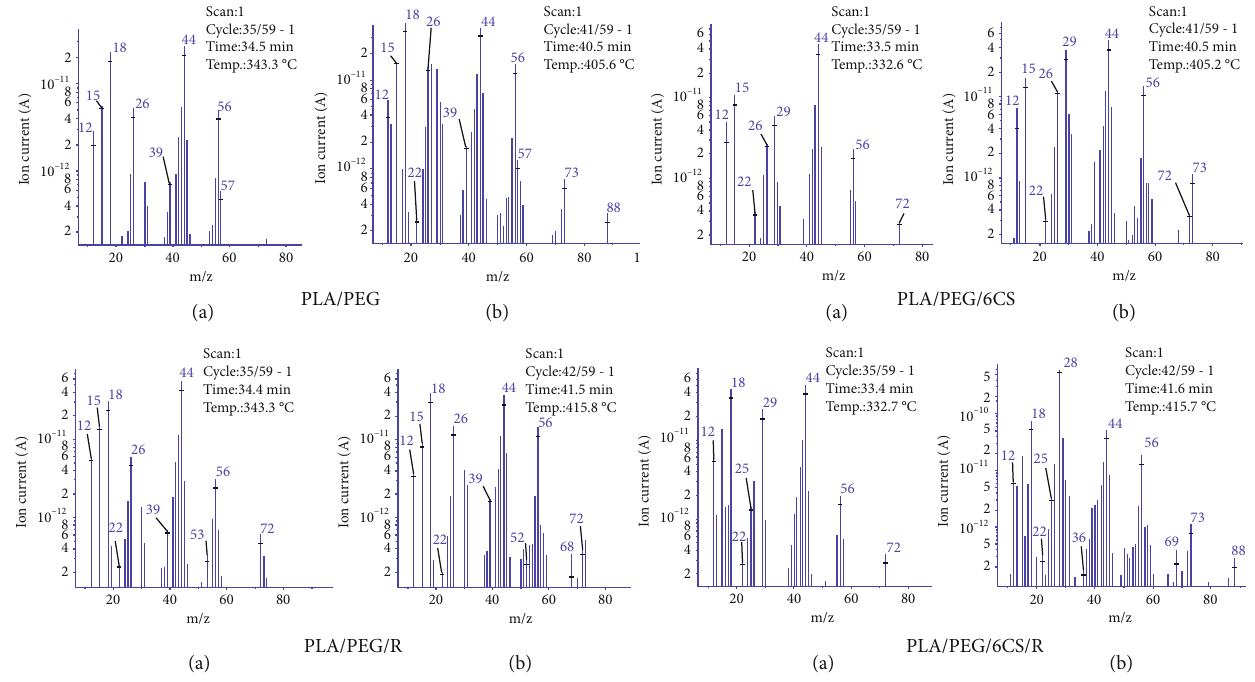
Figure 10: MS spectra corresponding to a maximum decomposition rate temperature of two steps in DTG curves: ~ 330-340 ° C (a) and 400- 415 ° C